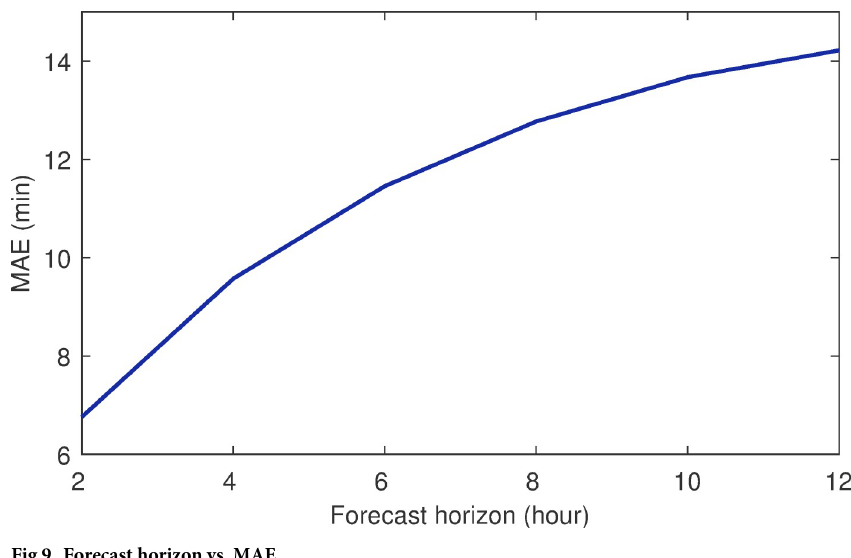
Fig 9. Forecast horizon vs.